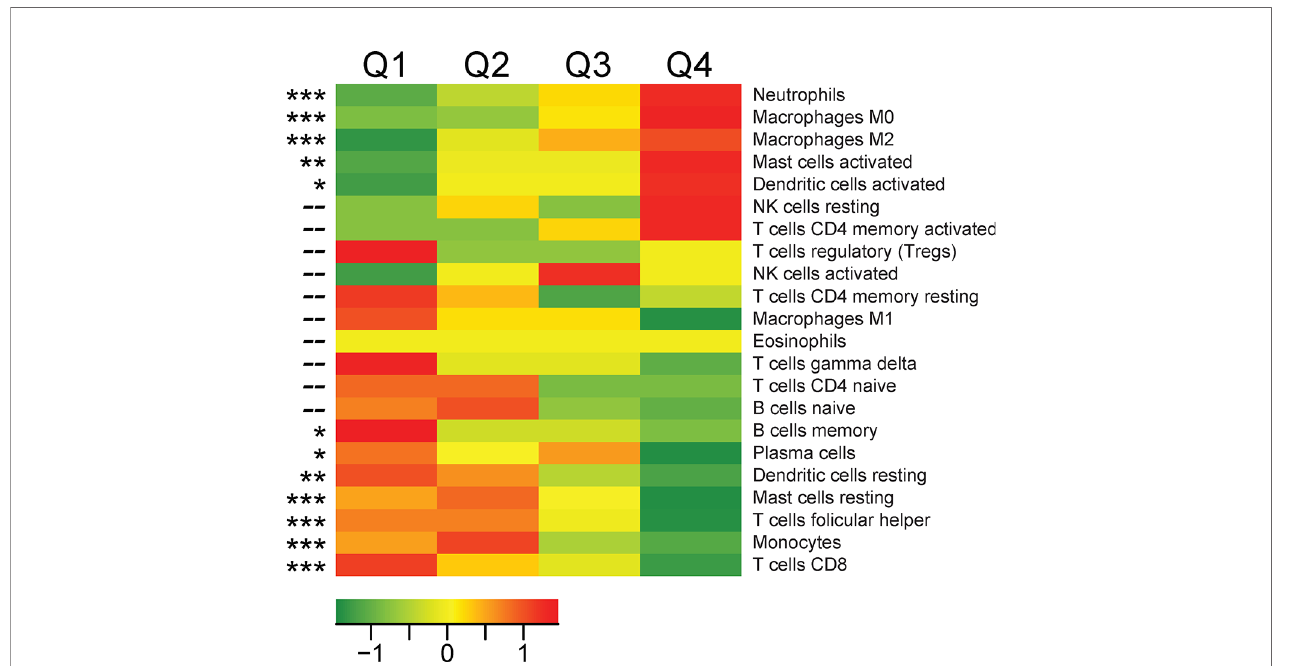
FIGURE 4 | Associations between TREM1 expression quartiles and abundance of leukocyte populations in breast tumors. For each tumor of the MC1 cohort, a CIBERSORT estimate of relative immune cell proportion was computed for each of 22 immune cell types. Heat map values represent the mean CIBERSORT immune cell proportions for each quartile of TREM1 expression (mean-centered). Red color, high average cell proportion; green color, low average cell proportion. For cell types where cell abundance correlates positively or negatively with TREM1 expression quartiles, Spearman correlation p-values are shown. *P < 0.05; **P < 0.01; ***P <